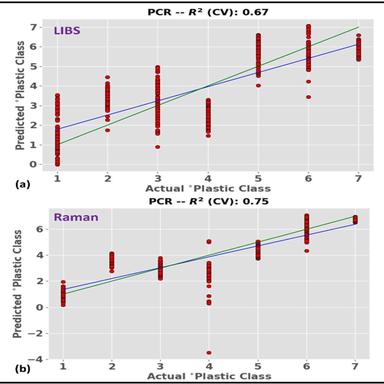
PCR cross-validation of spectral data collected from plastic samples (a) LIBS and (b) Raman data (labels: 1-PET, 2-HDPE, 3-PVC, 4-LDPE, 5-PP, 6-PS, and 7-PMMA).